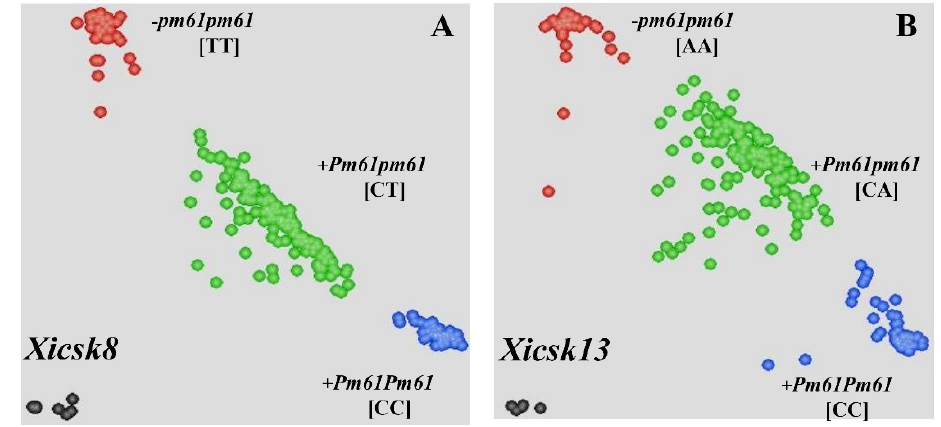
Figure 4. Genotyping results of Xicsk8 ( A ) and Xicsk13 ( B ) by Kompetitive Allele Specific PCR (KASP) assay. The scatter plot with the axes x and y represents the allelic discrimination of Xicsk8 or Xicsk13 genotypes. The red, green and blue dots represent the homozygously susceptible, heterozygous, and homozygously resistant F 2:3 lines from the mapping population of the Xuxusanyuehuang × Zhongzuo 9504 cross, respectively.